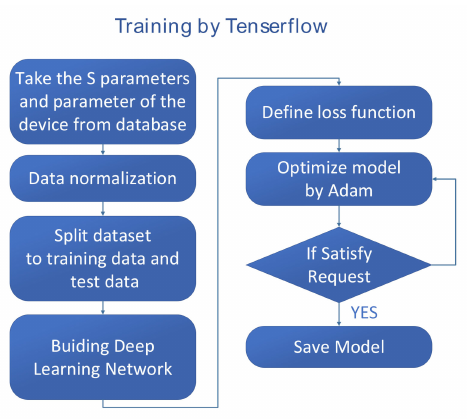
Figure 1. Outline flowchart of this work.